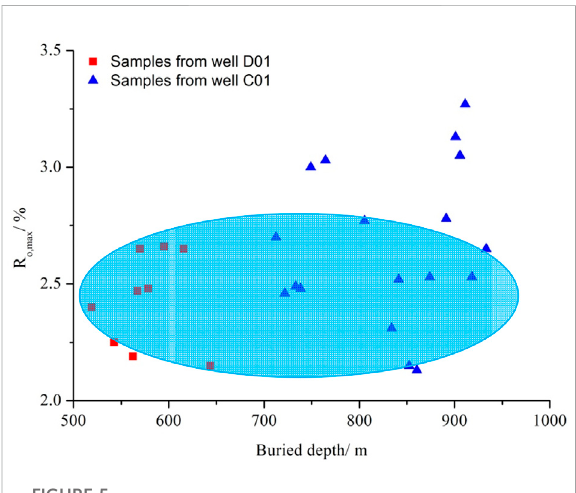
FIGURE 5 R o,max values for the core samples from wells D01 and C01.